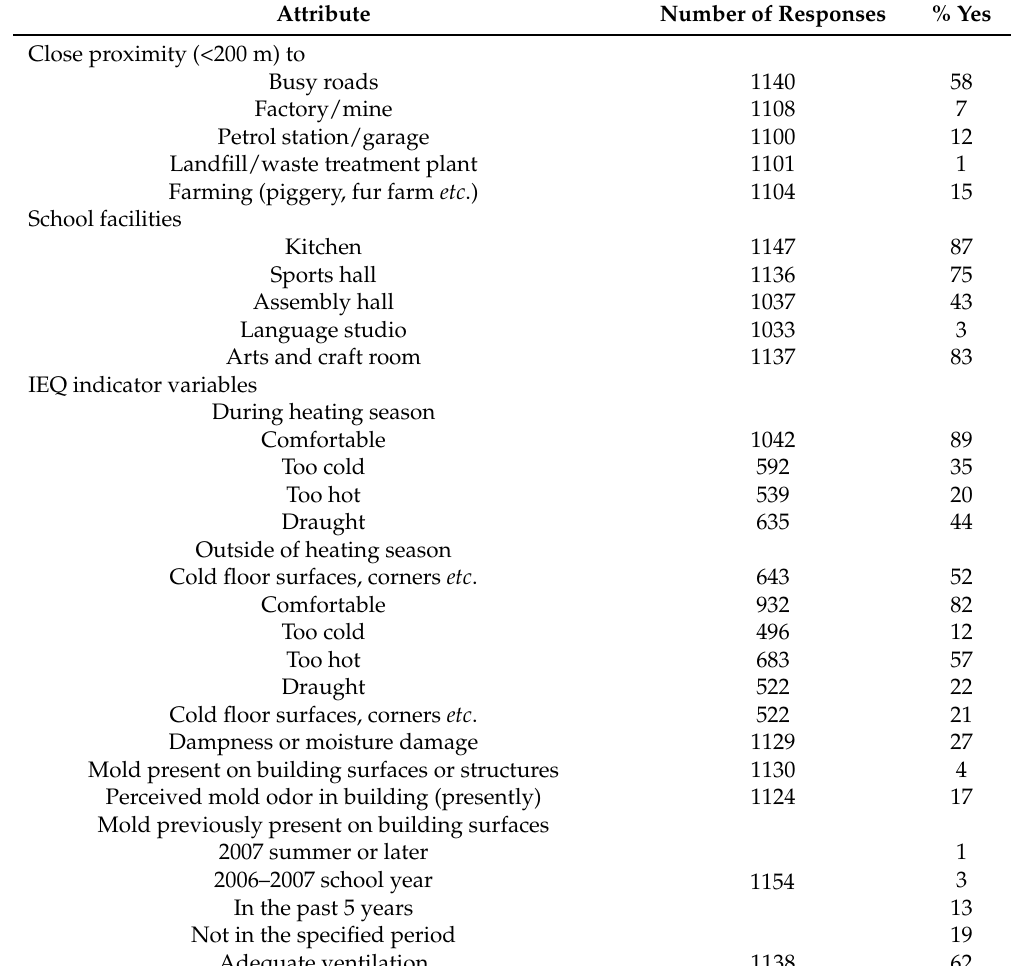
Table 2. Characteristics of the